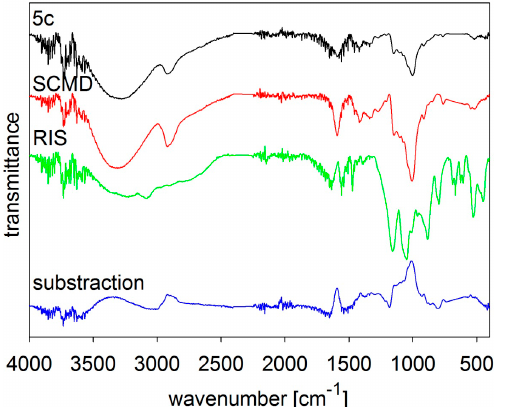
Figure 6. MIR spectra of risedronate (RIS), sodium carboxymethyl dextran (SCMD) and risedronate nanoparticles stabilized with 5% concentration of sodium carboxymethyl dextran (Sample 5c ) and differential